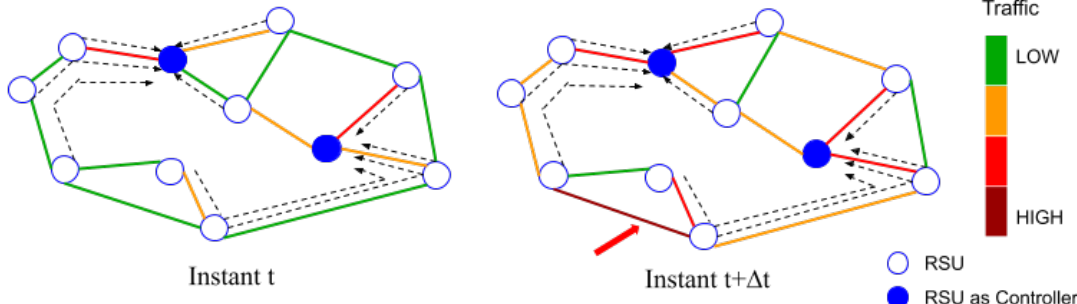
Figure 4. Simplified representation of traffic changes during the